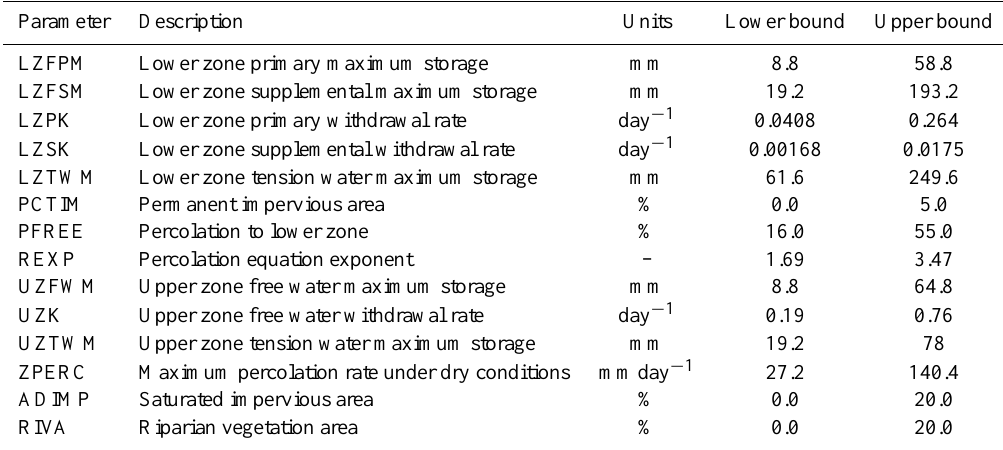
Fig. 2. Hourly streamflow and precipitation values during the six-month simulation period for the Blue River basin. The y axis on the left side of each plot represents abstracted spatial information, where the 78 grid cells of the basin model are sorted from the outlet cell (1) to the cell furthest from the outlet (78). The y axis on the right side of each plot shows the magnitude of streamflow. The color corresponds to the amount of precipitation at each hourly time step. Time periods (1) , (2) , and (3) are highlighted for further analysis, with (1) and (2) representing large events with different spatial distributions of precipitation, and (3) representing a low-flow period. Note that hours with high precipitation are more visible in time periods (1) – (3) than in the six-month simulation period due to the reduced width of hourly intervals when plotting over the full period. Table 1. HL-RDHM parameters and their uniform sampling ranges for sensitivity analysis.